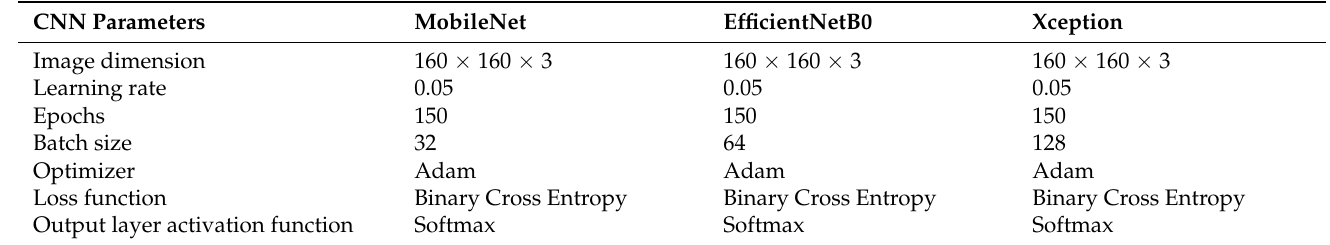
Table 1. CNN training parameters.